Question: Give a one-sentence summary of this figure.
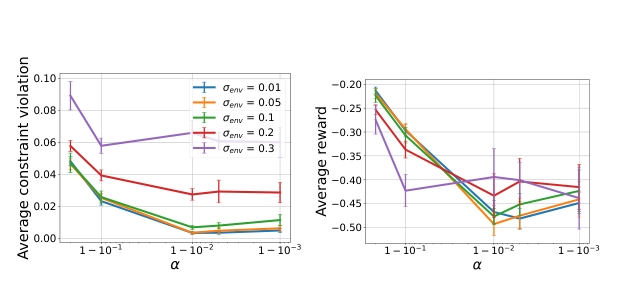
Answer: Impact α on the execution performance of RANCB. Av- erage constraint violation per step (left) and average reward (right).